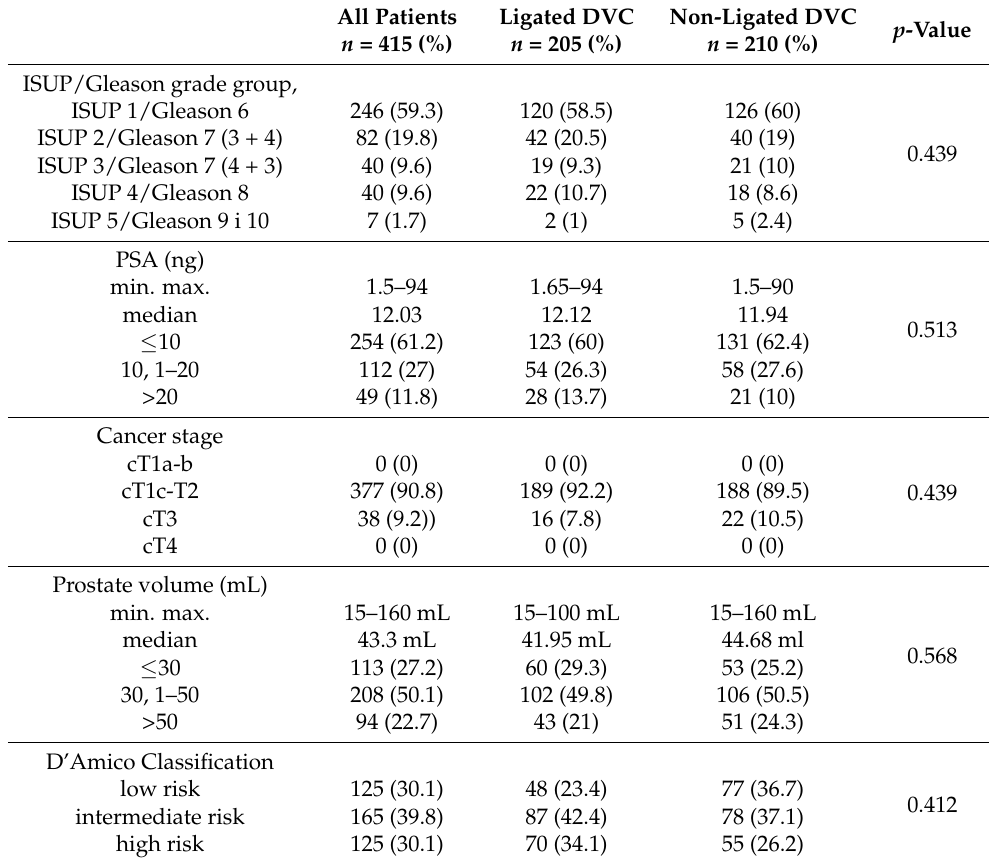
Table 1. Preoperative characteristic of patients included in the study.